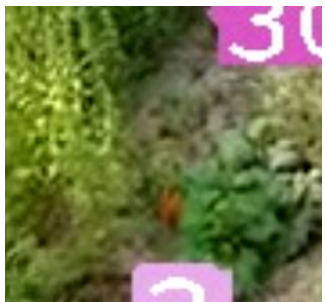
Figure 15. Pumpkin is mostly hidden and is hard to be seen due to little to no lighting, in further frames the pumpkin only becomes more hidden and is never detected.